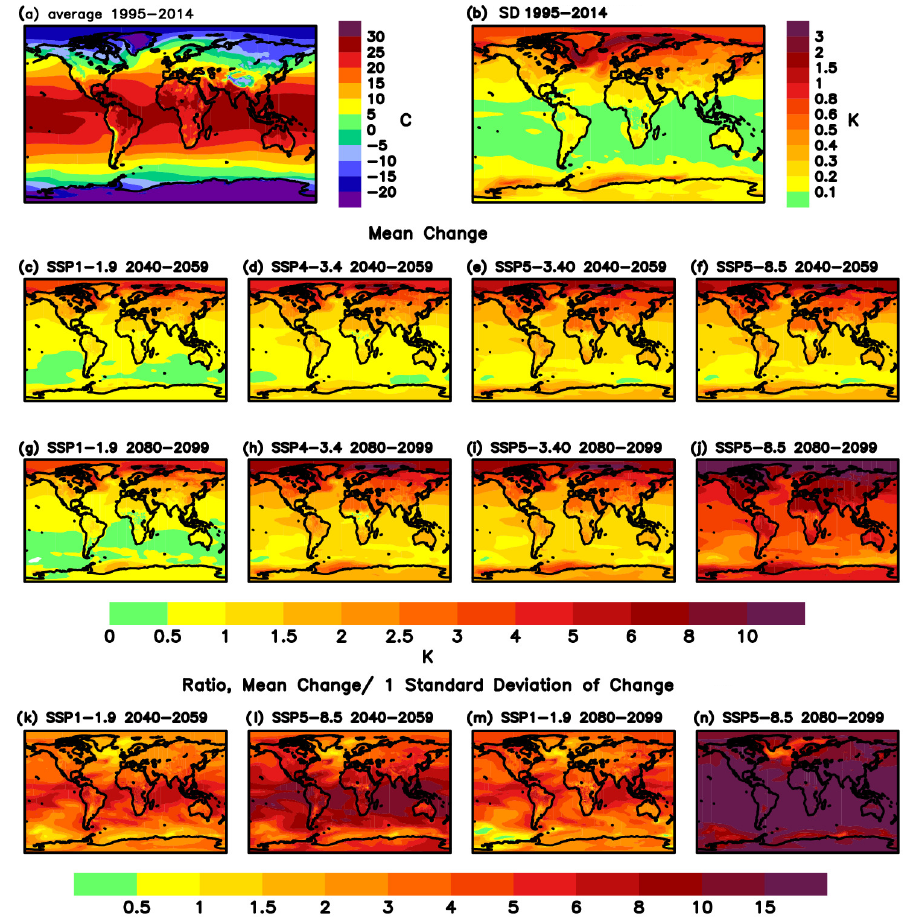
Figure 3. (a) Ensemble mean annual mean 2m air temperature, averaged over 1995–2014. (b) One standard deviation of annual mean 2m air temperature, averaged over 1995–2014, across ensemble members. (c–f) Ensemble mean 2m air temperature change between 2040–2059 and 1995–2014 for SSP1-1.9, SSP4-3.4, SSP5-3.4-OS, and SSP5-8.5. All colored areas show significant changes at the 95% significance level based on a two-sided Student t test. (g–j) Same as (c–f) but for changes until 2080–2099. (k–n) Ratio between mean 2m air temperature change between 2040–2059 (2080–2099 in m and n ) and 1995–2014 and 1 standard deviation of the variability of temperature change across ensemble members in SSP1-1.9 (k, m) and SSP5-8.5 (l, n) . The change is calculated for each individual ensemble member as the difference between temperature in the future period (average over 2040–2059 or 2080–2099) and the temperature of the reference period (average over 1995–2014) in the same ensemble